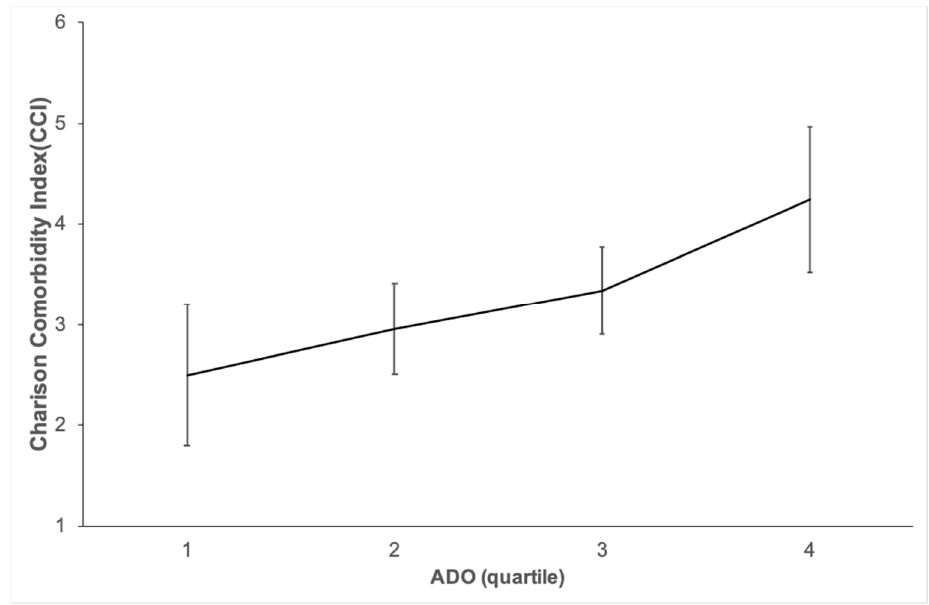
Figure 2. This shows the good correlation between the ADO quartiles and the Charlson comorbidity index (CCI) ( p < 0.001). index (CCI) ( p <